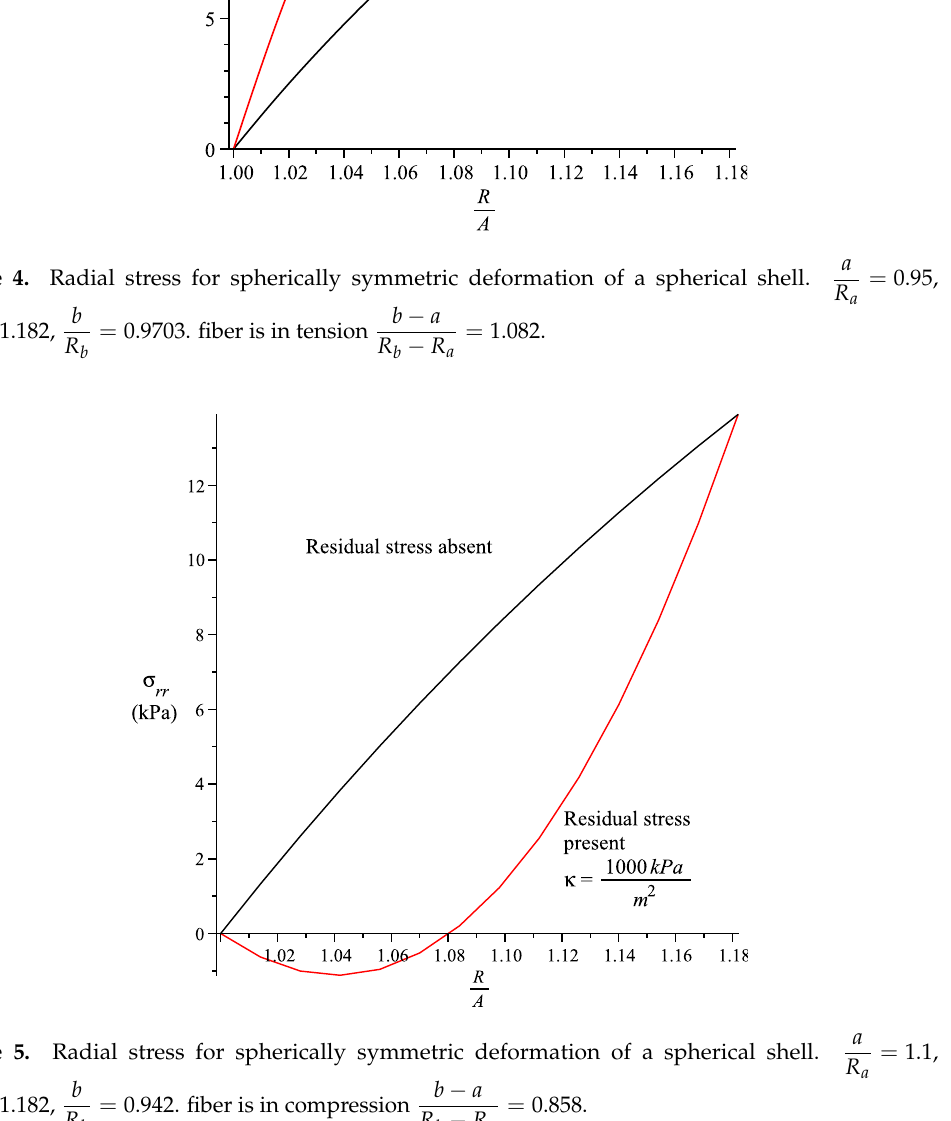
Figure 5. Radial stress for spherically symmetric deformation of a spherical shell. R b b = 1.182, = 0.942. fiber is in compression R a R b